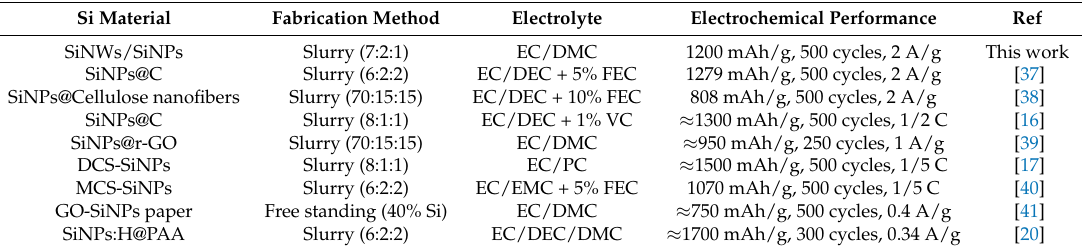
Table 1. Key parameters and electrochemical performance of our 0D-1D hybrid composite and several nanoSi-based state-of-the-art anodes reported in the literature. Only references showing long cycling stability (>200 cycles) were included in this table.